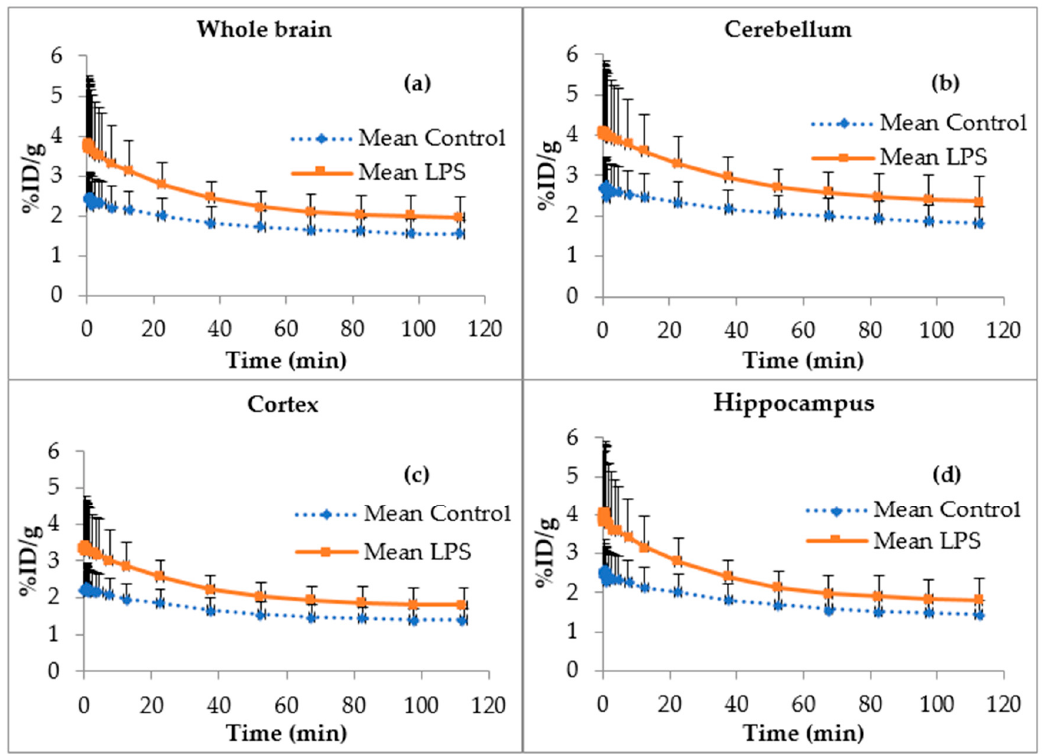
Figure 7. Parent fraction of [ 18 F]FEPPA Time Activity Curve in %ID/g ± SD control vs. LPS. ( a ) Mean in whole brain ( p = 0.0063); ( b ) Mean in cerebellum ( p = 0.0179); ( c ) Mean in cortex ( p = 0.0126); ( d ) Mean in hippocampus ( p = 0.0266) (n = 8 controls and 7 LPS).